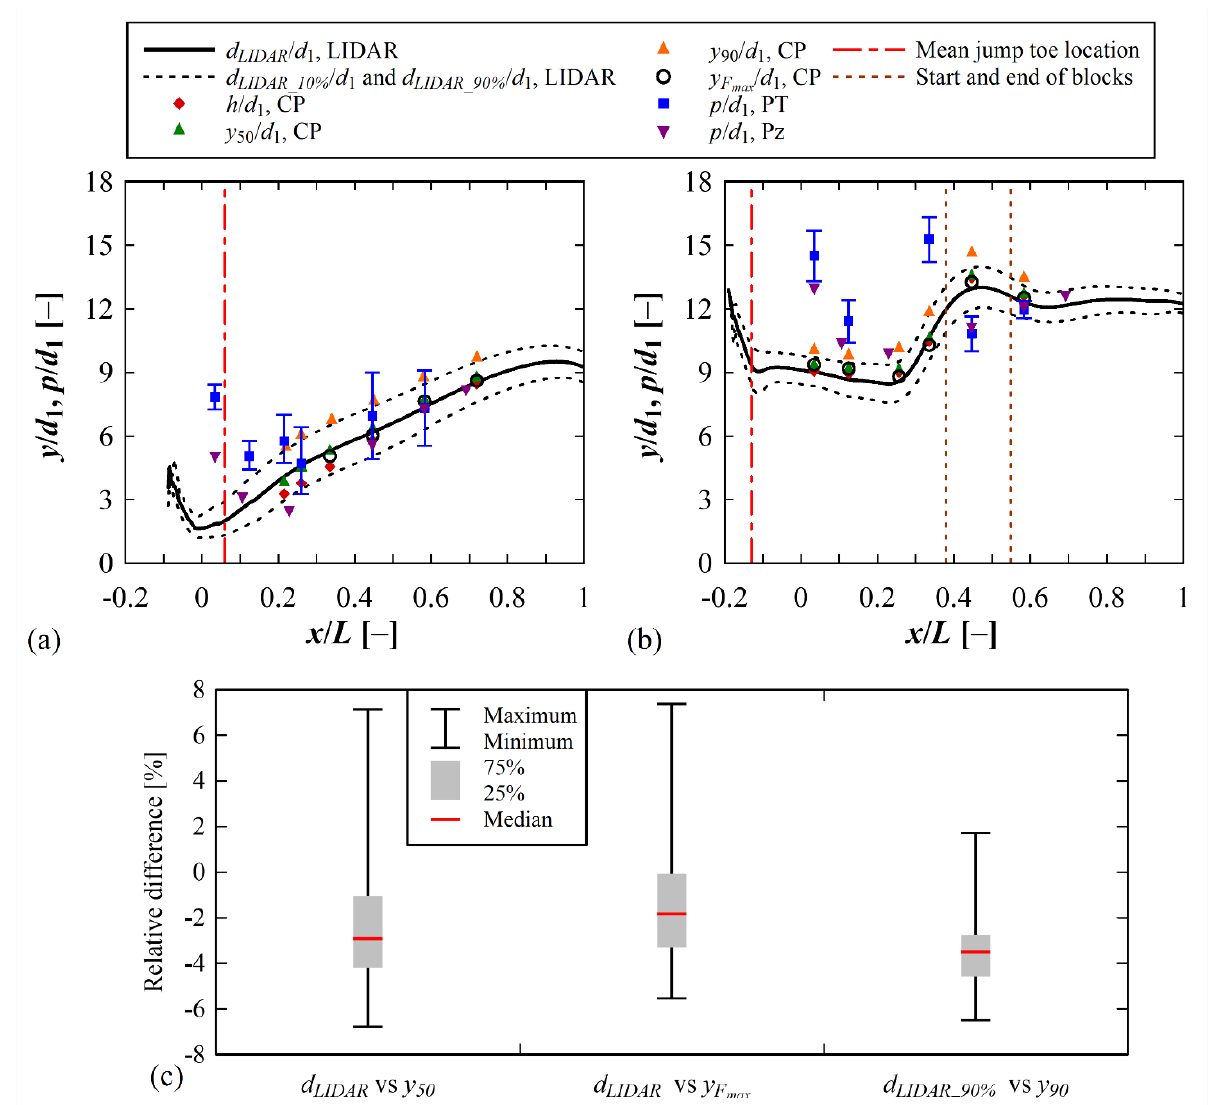
Figure 8. Comparison of mean free-surface elevations measured with LIDAR d LIDAR / d 1 , mean pressure heads p / d 1 measured with dynamic pressure sensors (PT) and piezometers (Pz) as well as characteristic air – water flow elevations measured with the conductivity probe (CP): ( a ) without super-cavitating blocks; q = 0.15 m 2 /s, Fr 1 = 8.7, Re = 1.5 × 10 5 , z / W = 0.26; ( b ) with super-cavitating blocks; q = 0.13 m 2 /s, Fr 1 = 9.4, Re = 1.3 × 10 5 , z / W = 0.11; ( c ) relative difference between elevations measured with LIDAR- and characteristic air – water flow depths; note that a negative/positive relative difference means that a LIDAR elevation was below/above a characteristic air – water flow depth.